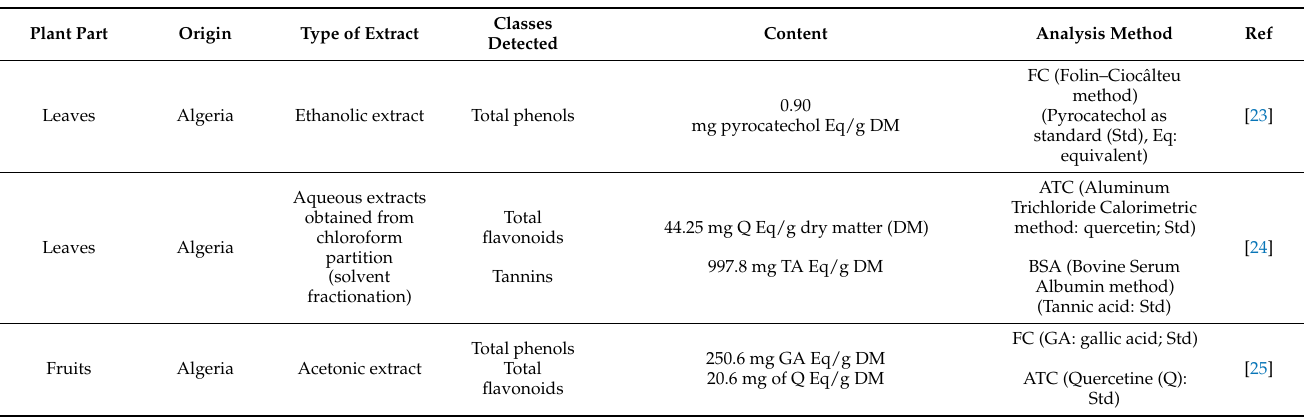
Table 1. Lentisk phenolic